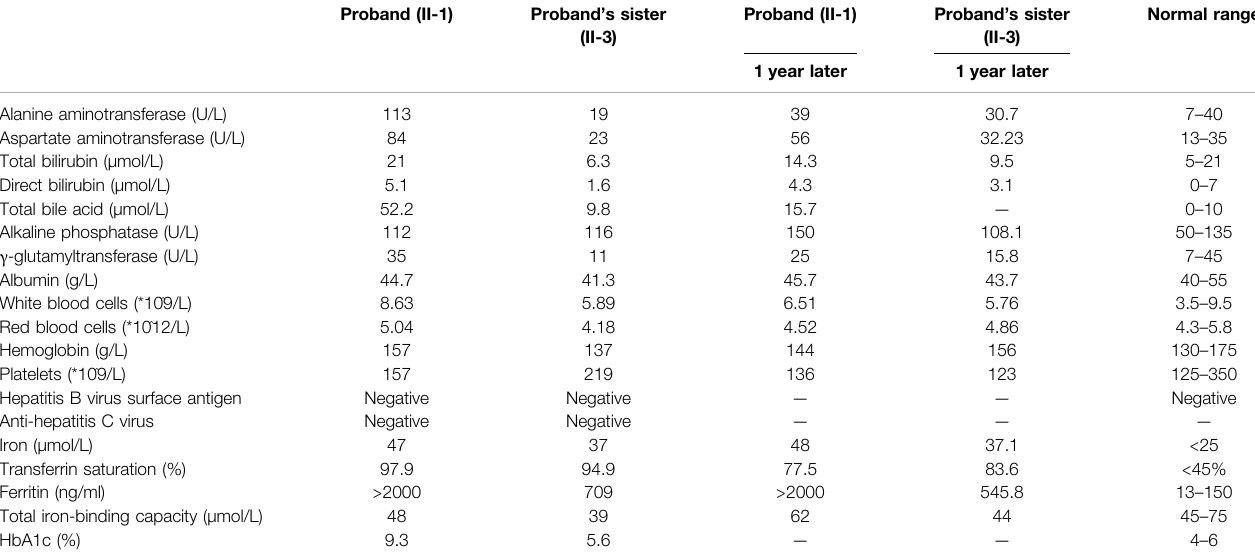
TABLE 1 | Laboratory test results of the proband and the proband ’ s